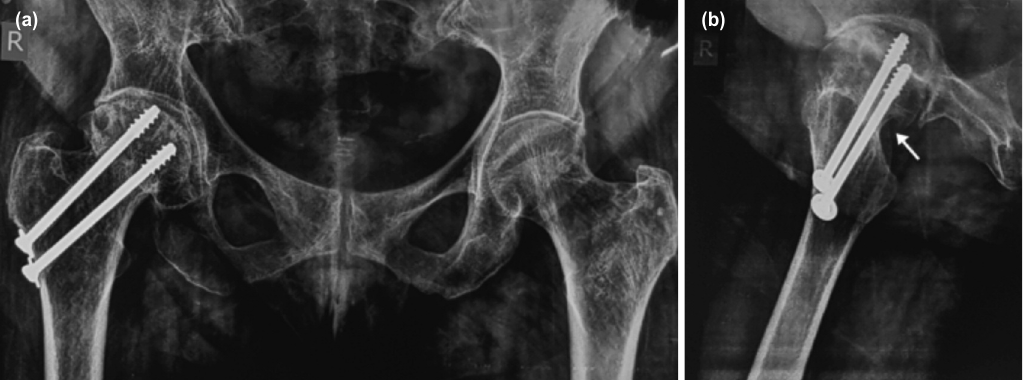
Pre-operative anteroposterior radiograph of both hips (a) with collapse femoral head, implant in situ and screw cut out and Fig. 1: lateral radiograph of right hip (b) with screw abutment marked with white arrow at inferior femoral neck region.